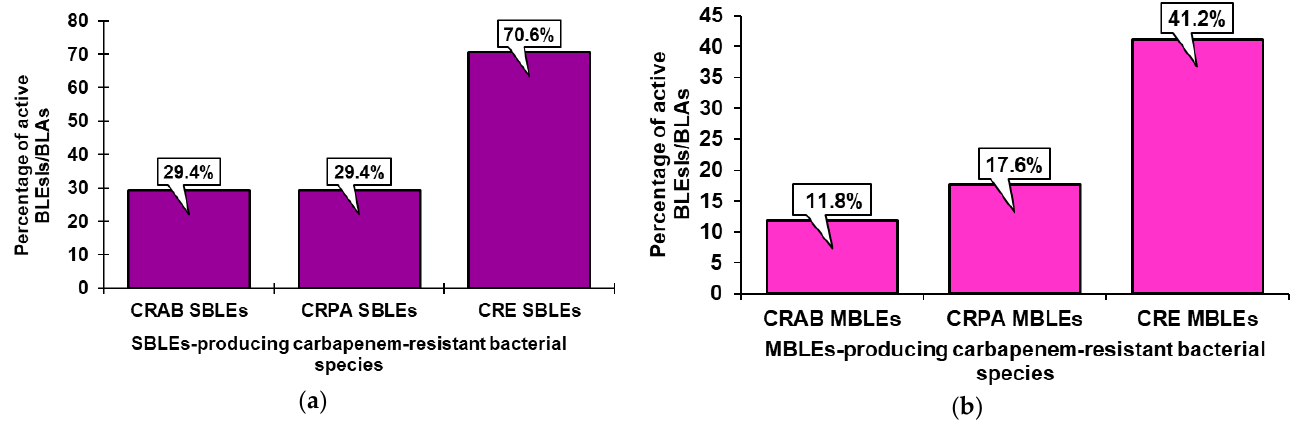
Figure 11. Percentages of all combinations active on the different carbapenem-resistant bacterial species producing SBLEs ( a ), and those of combinations that were affective on the same species producing MBLEs ( b ).